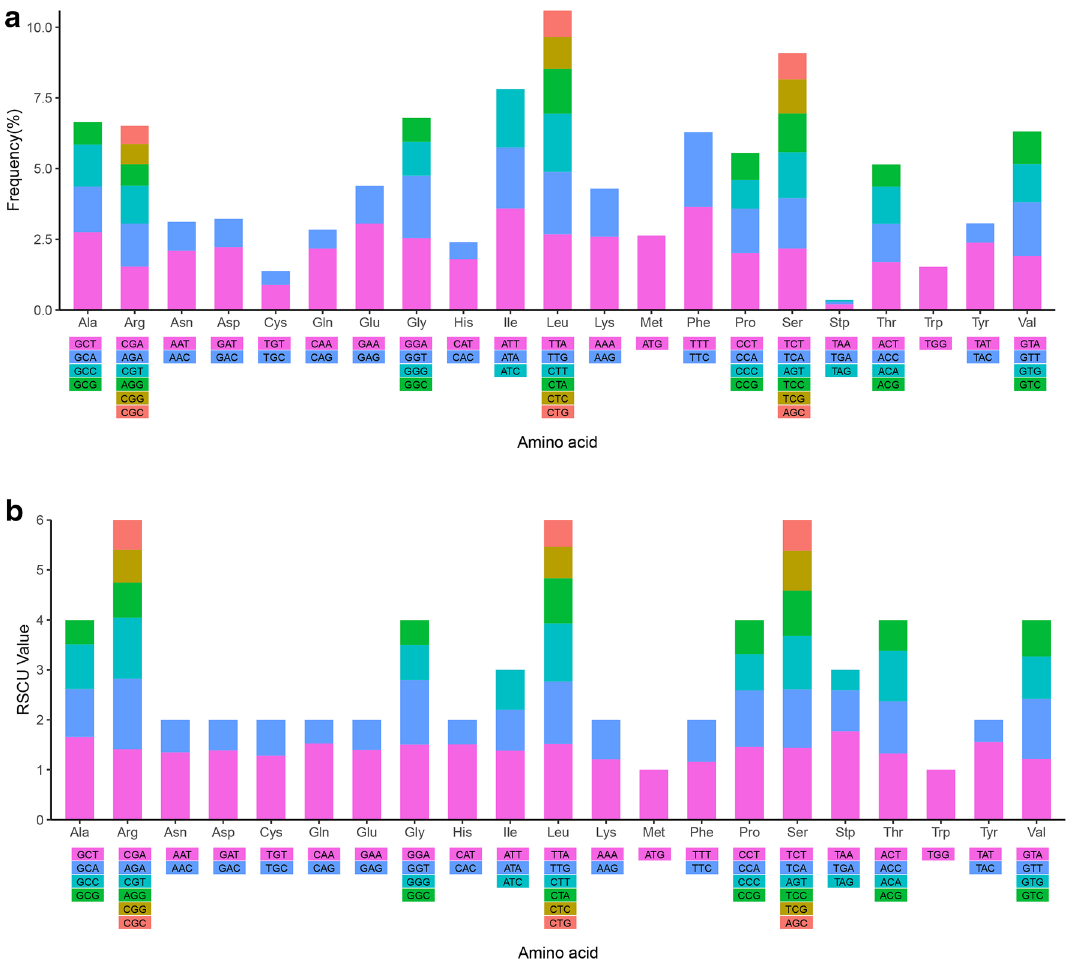
Figure 2. Amino acid frequency and RSCU value of protein-coding genes in mitochondrial genome of Neolamarckia cadamba